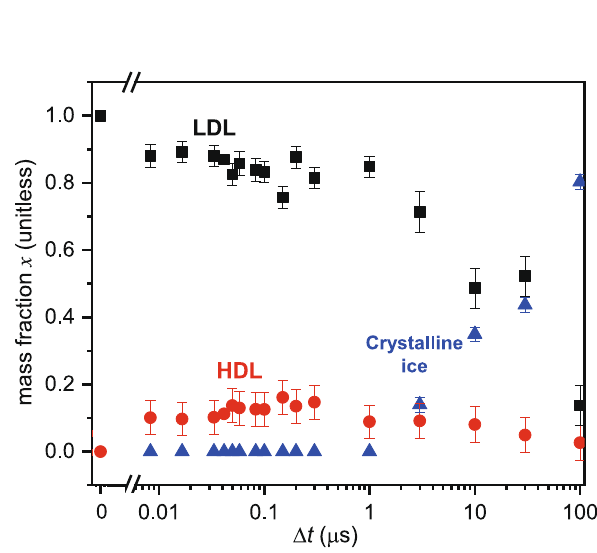
Fig. 4 | Time evolution of LDL, HDL and ice components after heating. Mass fraction of LDL (black squares), HDL (red circles), and crystalline ice (blue tri- angles) as a function of the pump-probe delay time Δ t . Each data point is obtained by fi tting our Δ I ( q ) curves, averaged over three x-ray shots, to a sum of contributions due to LDA, HDA and crystalline ice, using the same procedure as described in ref. 8 . The error bars show the standard error for each data point determined by propagating the error associated with the averaged Δ I ( q )